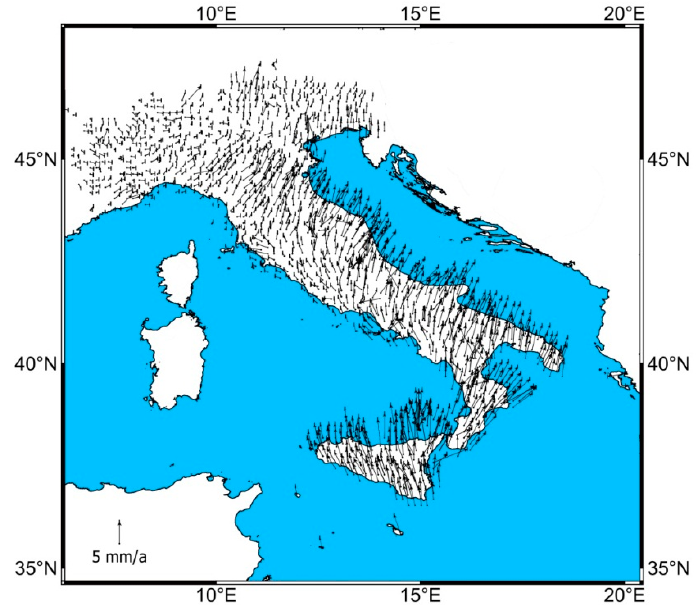
Figure 7. Horizontal velocity map derived by the combination of GNSS and PS radar interferometry aligned with respect to the Eurasian reference system(ETRS89), with 95% confidence level uncertainty ellipses.